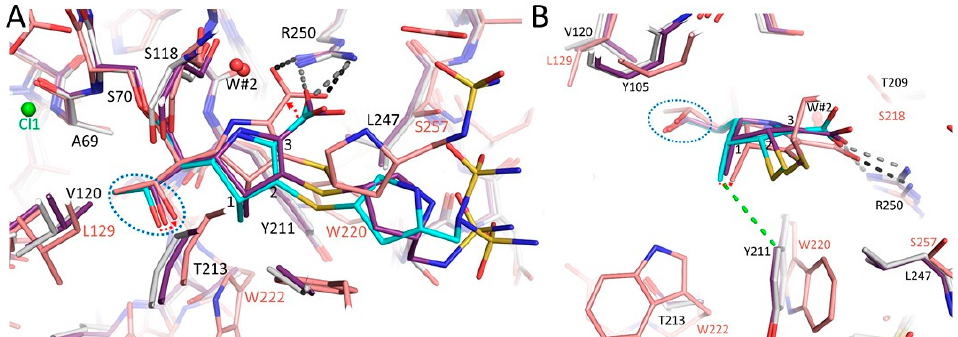
Figure 5. Superposition of the doripenem-bound complexes of OXA-51 I129L / K83D and OXA-48 K73A. ( A ) OXA-51 I129L / K83D, OXA-48 K73A molecules A and B are superpositioned. Carbon atoms for the OXA-51 complex are colored light pink, molecules A and B of OXA-48 K73A are colored as in Figure 3. Hydrogen bonds between the carboxyl moiety and R250 in the OXA-51 I129L / K83D structure are depicted as black dashed lines; hydrogen bonds between doripenem and that same R250 in the OXA-48 K73A molecule A structure are shown as grey dashed lines. The hydroxyethyl moiety of doripenem is highlighted by a blue dashed oval line; positions 1, 2, and 3 on the pyrrolidine ring are numbered. The rotation needed for doripenem’s pyrrolidine ring when bound to OXA-48 to achieve the binding mode as when bound to OXA-51 I129L / K83D is depicted by a small red dashed arrow. ( B ) Rotated such that view is perpendicular to that in ( A ). Van der Waals interaction between the methyl moiety of doripenem and Y211 in the OXA-48 K73A molecule A structure is depicted as a green dashed line.